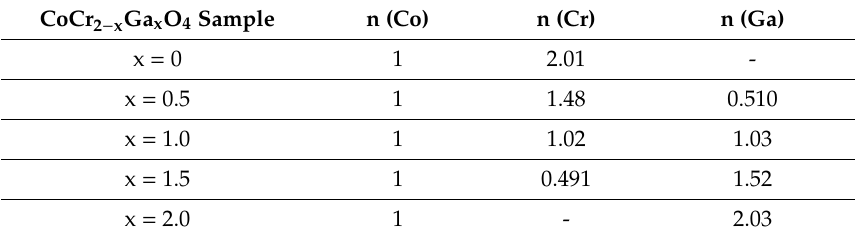
Table 1. The estimated crystallite size of the CoCr 2 − x Ga x O 4 powders synthesized at different temperatures. Table 2. The results of the elemental analysis of CoCr 2 − x Ga x O 4 powders by ICP-OES.